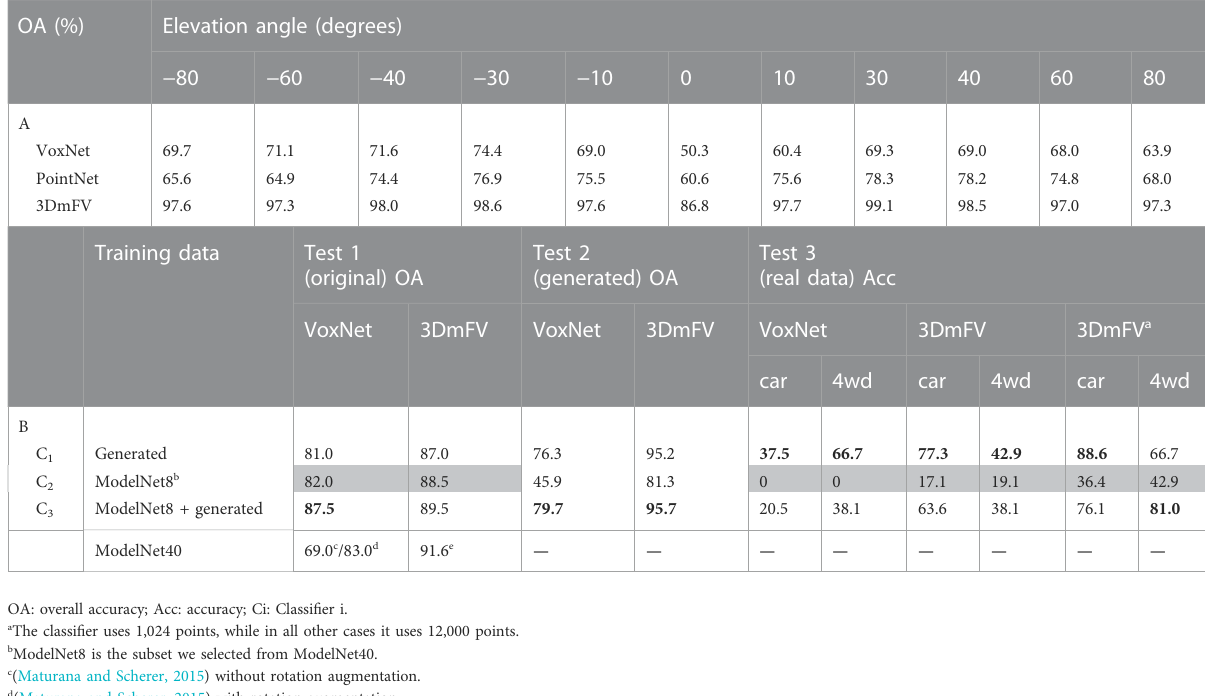
TABLE 3 Overall classi fi cation accuracy of the conducted experiments: (A) performance vs. elevation angle of the camera, (B) performance improvement by data augmentation.